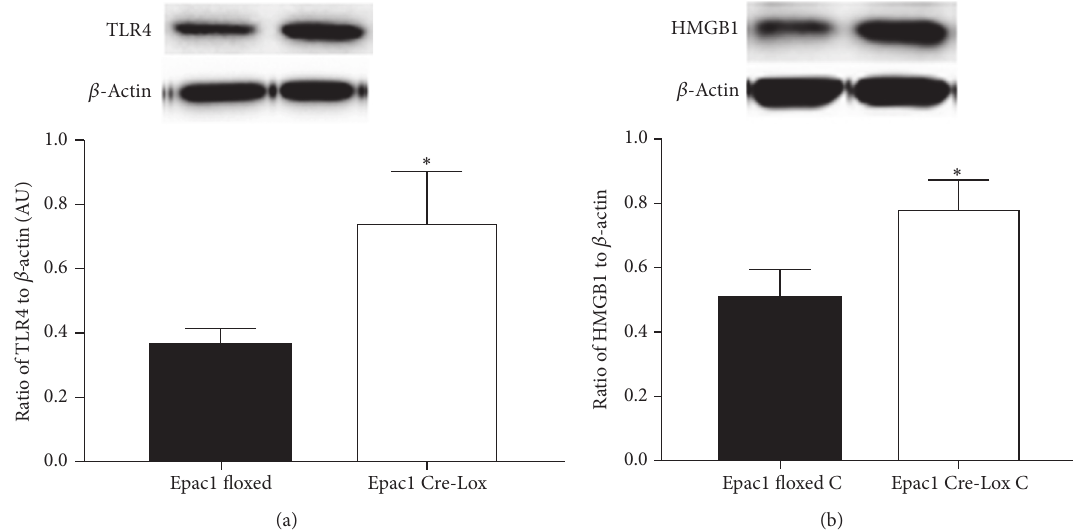
Figure 1: Loss of Epac1 increased TLR4 and cytosolic HMGB1. Western blot data from retinal lysates from Epac1 floxed and Epac1 Cre-Lox mice for TLR4 (a) and cytosolic HMGB1 (b). ∗ 𝑃 < 0.05 versus Epac1 floxed. 𝑁 = 6 . Data are mean ± SEM.